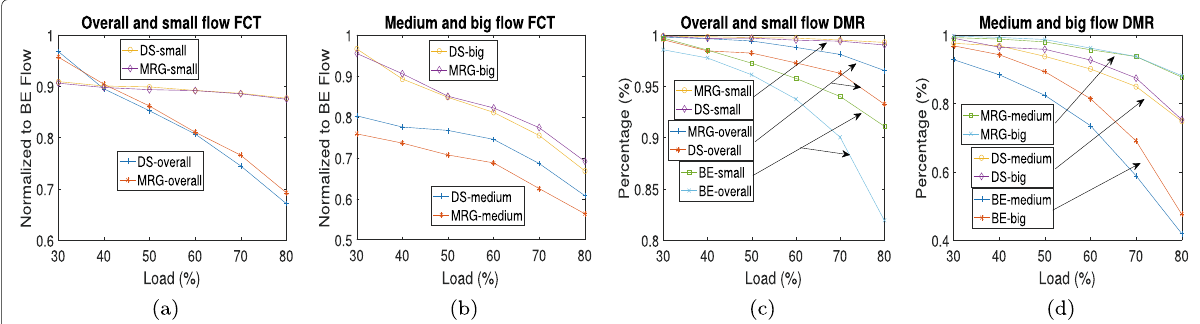
Fig. 9 VBP with Data-ming workload: ( a ) overall and small flow FCTs; ( b ) Medium and big flow FCTs; ( c ) Overall and small flow DMRs; and ( d ) Medium and big flow DMRs